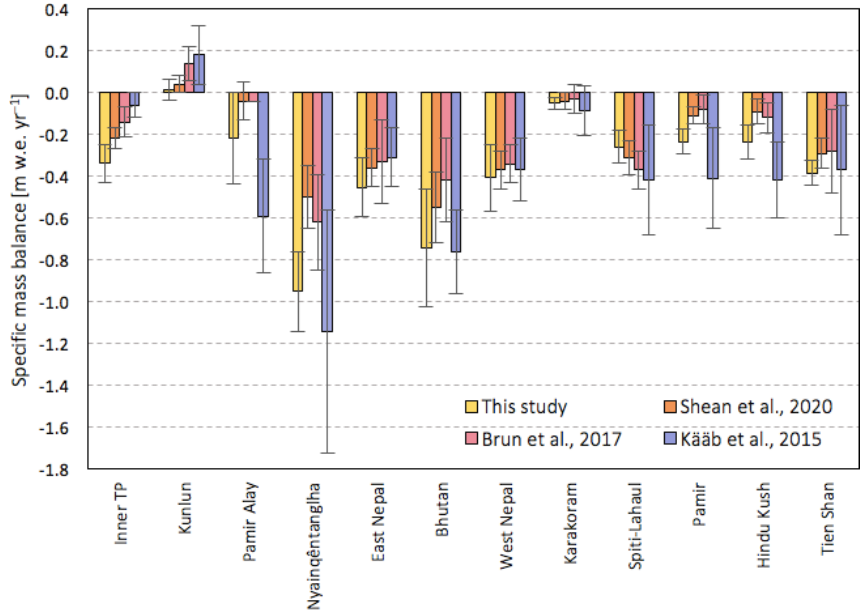
Figure 7. High Mountain Asia (HMA) specific mass balance trends on a sub-regional level (using the sub-regions of Brun et al., 2017) in comparison with DEM differencing and ICESat studies. It is important to note that Shean et al. (2020) cover the time period of 2000 to 2018, Brun et al. (2017) cover the time period of 2000 to 2016, and Kääb et al. (2015) cover the time period 2003 to 2008, whilst this study covers the time period of July 2010 to July 2019. We have complemented the data from Kääb et al. (2015) with ICESat data from Brun et al. (2017) for the sub-regions Kunlun, inner TP (Tibetan Plateau), Tien Shan and Pamir Alay, which extended the estimates of Kääb et al. (2015) using the same